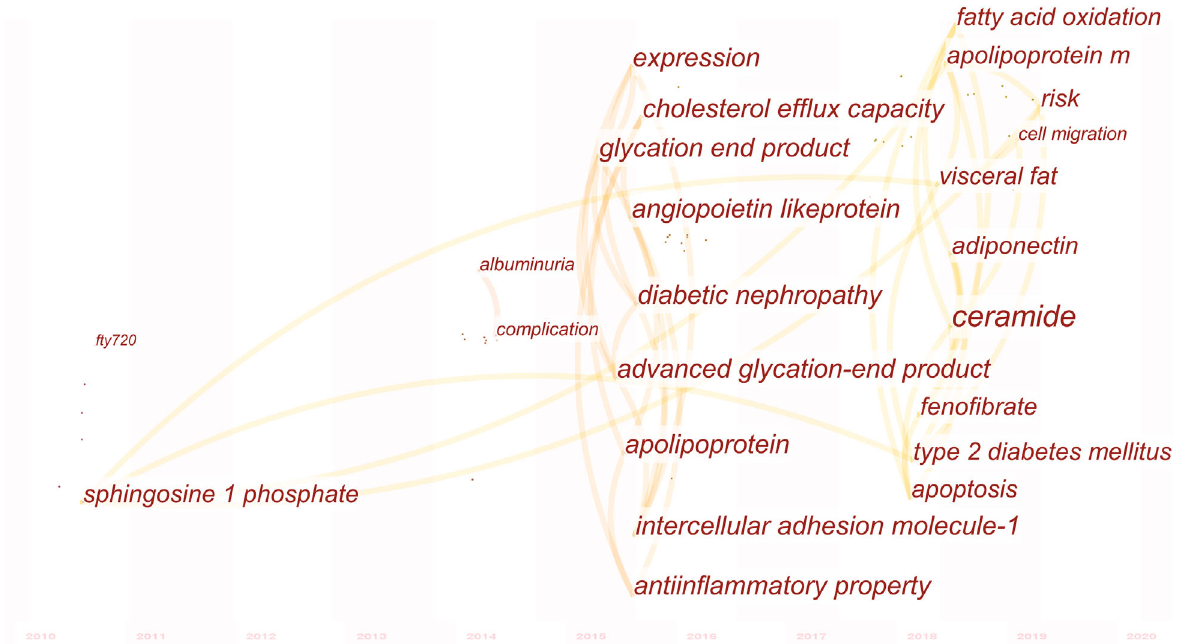
Figure 9: Timeline view of the keywords in diabetes from 2010 to